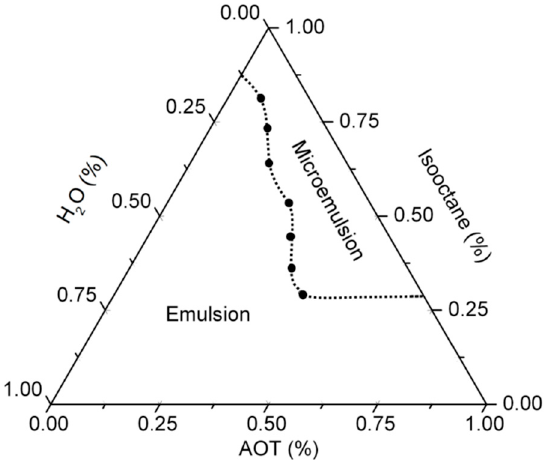
Figure 1. Pseudothernary phase diagram obtained for the system based on H 2 O / trimethylpentane (isooctane) / dioctyl sulfosuccinate sodium salt (Aerosol OT, AOT). The white point corresponds with the employed formulation for hyaluronic acid (HA) nanogel preparation.